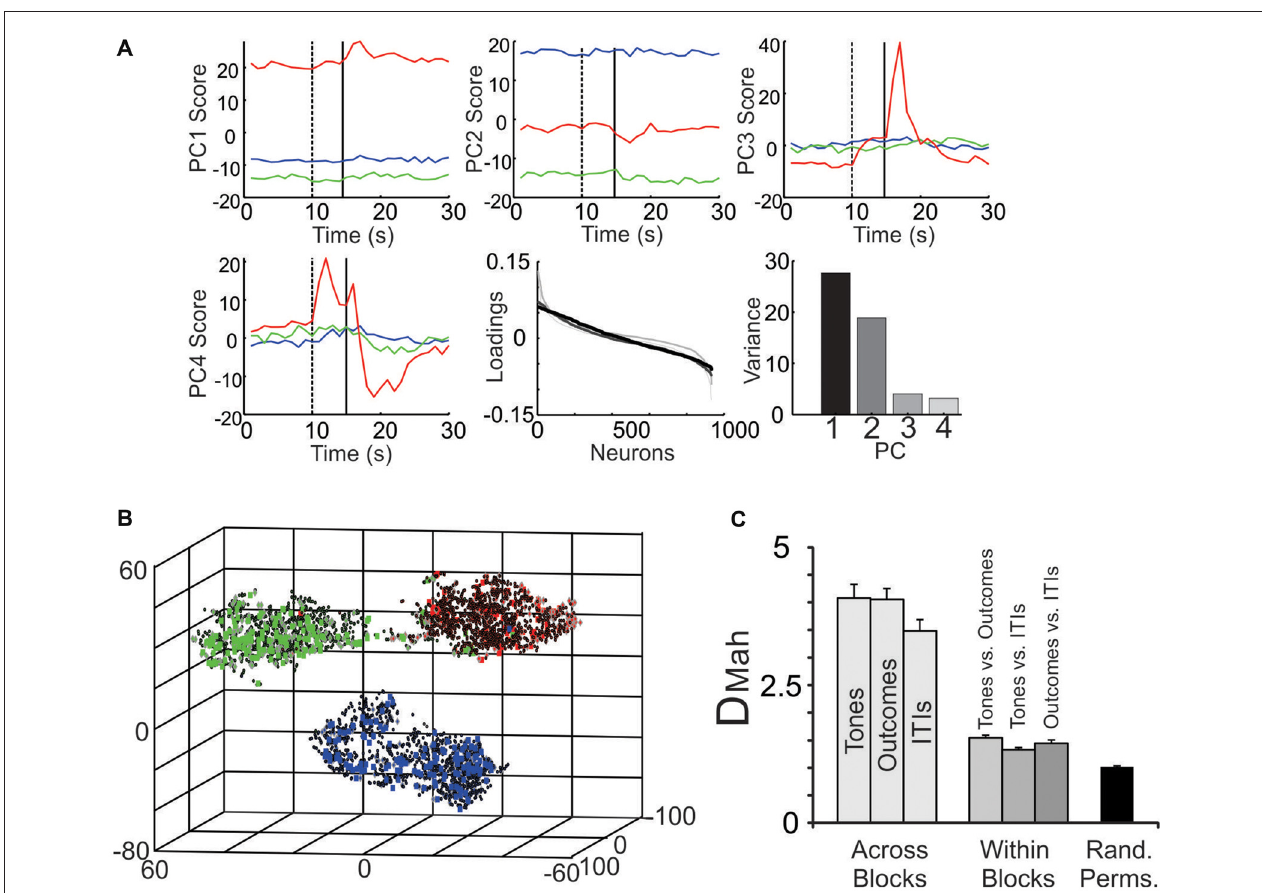
FIGURE 6 | Parsing block-specific ensemble dynamics. (A) Decomposition of ensemble signals using PCA. When PCA was performed on all 934 neurons, PC1 (top left) and PC2 (top middle) showed strong block offsets, while PC3 (top right) and PC4 (bottom left) exhibited fluctuations mainly during the tone and outcome periods, especially of the S-block. In all panels PCs during the S-block are in red, the F-block in green and the N-block in blue. The dotted vertical line denotes tone onset and the solid line denotes outcome onset. (Bottom middle) The loadings of the neurons on the top four PCs. The loadings are color-coded based on their ranking starting with PC1 (black) and going to PC4 (light gray). Note that in this figure, the relative positions of the neurons on the x-axis varied by PC. (Bottom right) The portion of variance accounted for by each PC. (B) The multiple single unit activity (MSUA) space from a single session was reduced to three dimensions for visualization using t-distributed stochastic neighbor embedding (t-SNE). Each point in the space represents the activity of the ensemble during a single 1 s time bin. The gray diamonds are derived from time bins when tones were presented, the squares from time bins when the outcomes were delivered (specifically, the 0–5 s following the tones) and the black dots from time bins associated with the inter-trial intervals (ITIs). Each symbol is filled based on the block from which it was derived (F-block = green, the N-block = blue, S-block = red). (C) The average Mahalanobis distance (D Mah and SEM) between the clusters of points corresponding to time bins associated with tone, outcome or ITI periods derived from different blocks (light gray bars), from within a single block (dark gray bars) or from time bins taken at random from throughout the task (black bar; Rand. Perms. = random permutations). Each light gray bar involves an averaging over all combinations of block pairs (N vs. F; N vs. S; F vs. S blocks) while all darker gray bars average over all